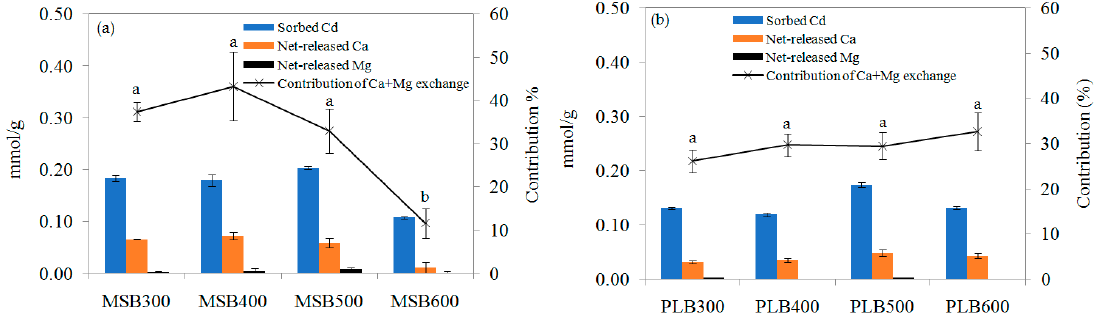
Figure 11. Net-released Ca 2+ and Mg 2+ during Cd adsorption for ( a ) MSB and ( b ) PLB pyrolyzed at 300, 400, 500 and 600 °C at pH 5.5.